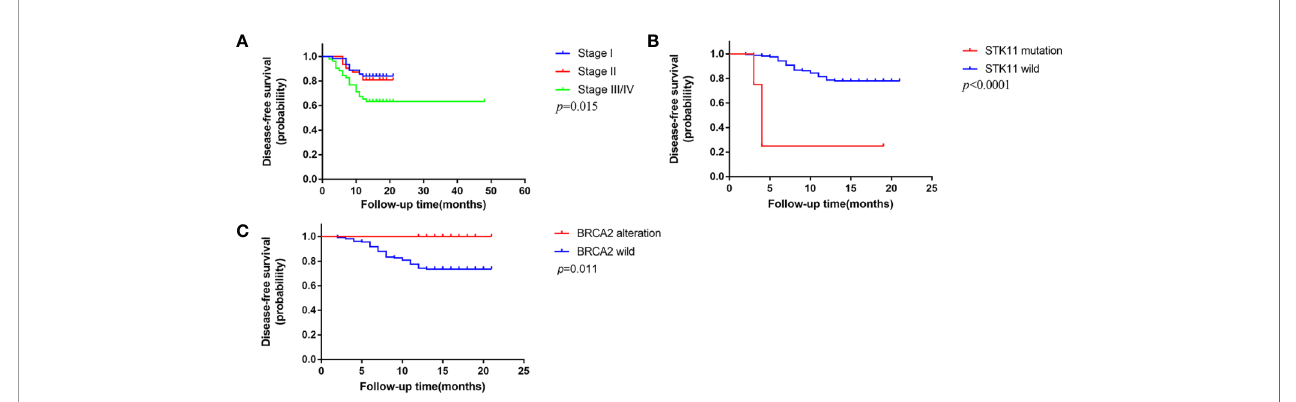
FIGURE 6 | One-year disease-free survival (DFS) in this cohort (A) . DFS based on pathologic stage (B) . DFS based on STK11 status (C) . DFS based on